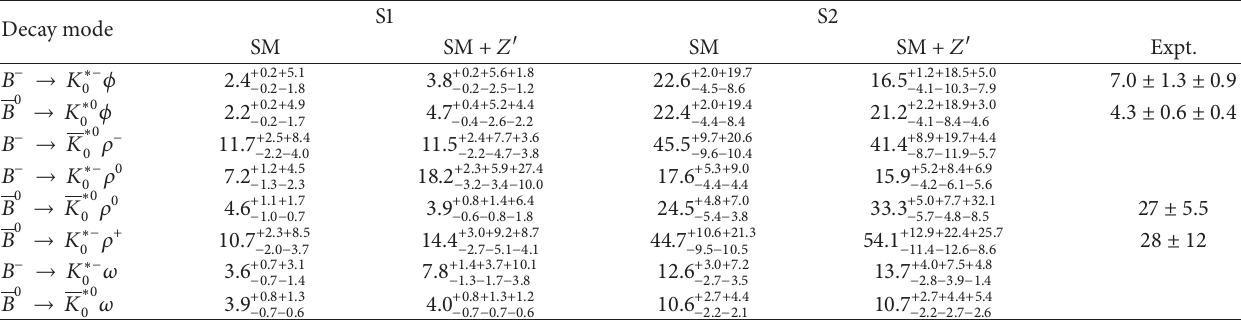
Table 4: Branching fractions (in units of 10 −6 ) under the different